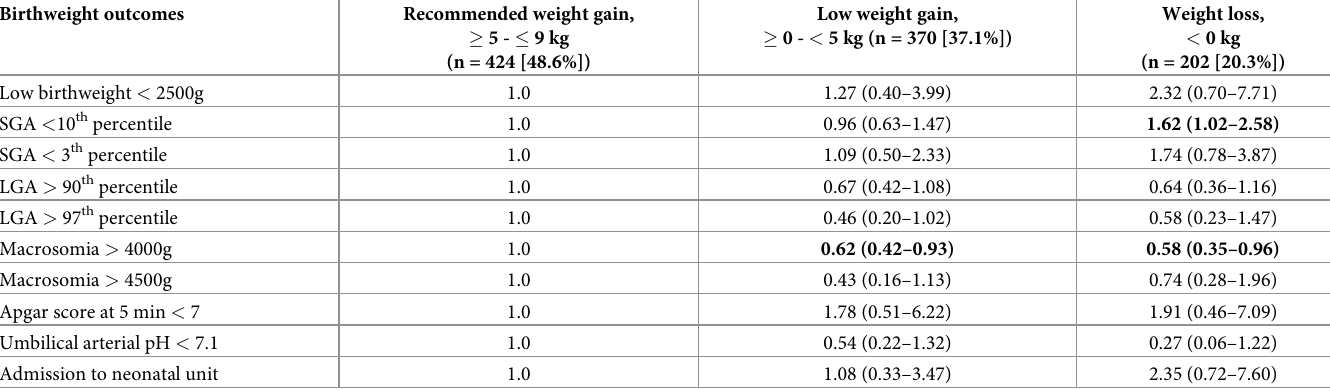
Table 3. Birthweight and neonatal outcomes associated with gestational weight gain or loss in women with class II obesity†. Birthweight